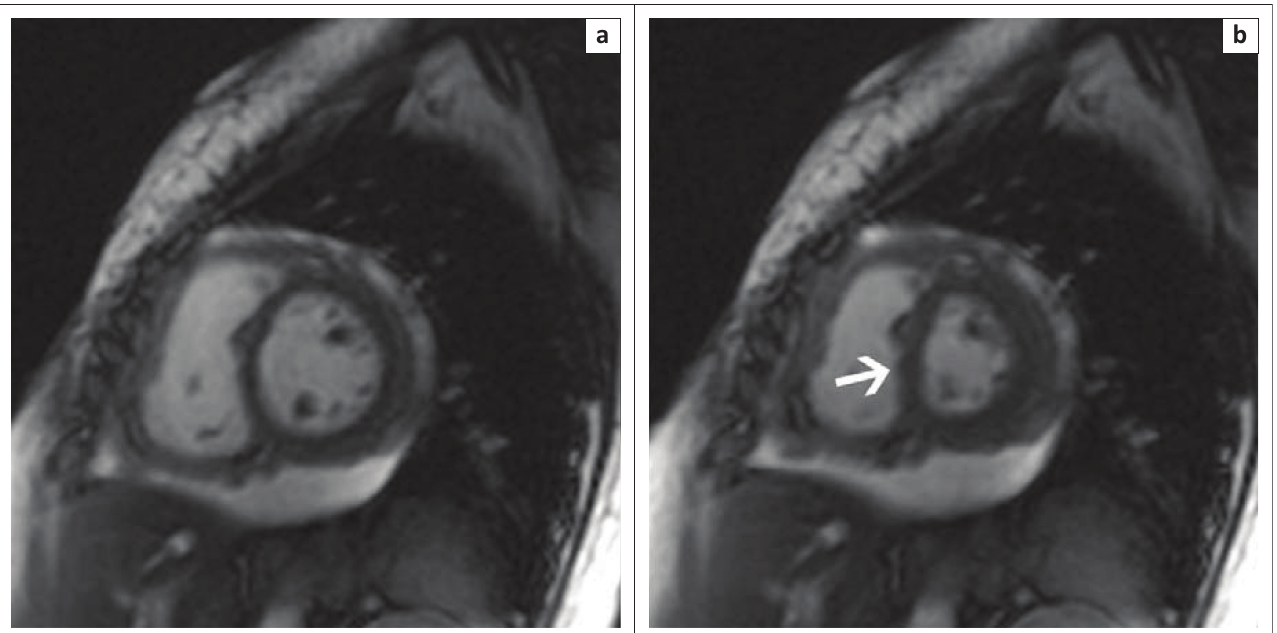
FIGURE 7: Short-axis SSFP sequences at end-diastole (left) and end-systole (right) show systolic flattening of the interventricular septum (white arrow) indicative of right ventricular pressure